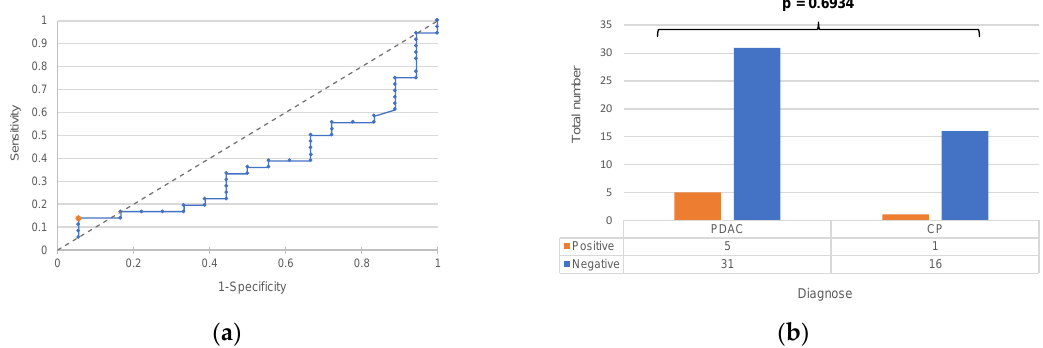
Figure 4. ( a ) ROC curve of a diagnostic test based on PD-L1. ( b ) Resulting contingency table of the test